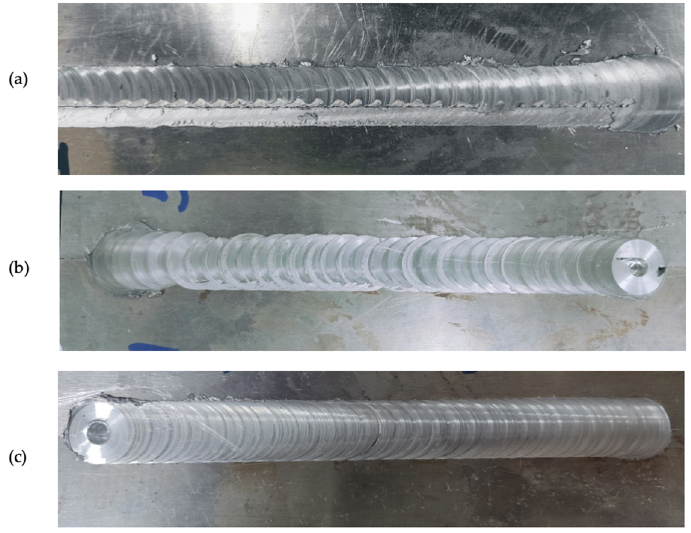
Figure 3. Example of ( a ) low-quality, ( b ) moderate-quality, and ( c ) high-quality weld